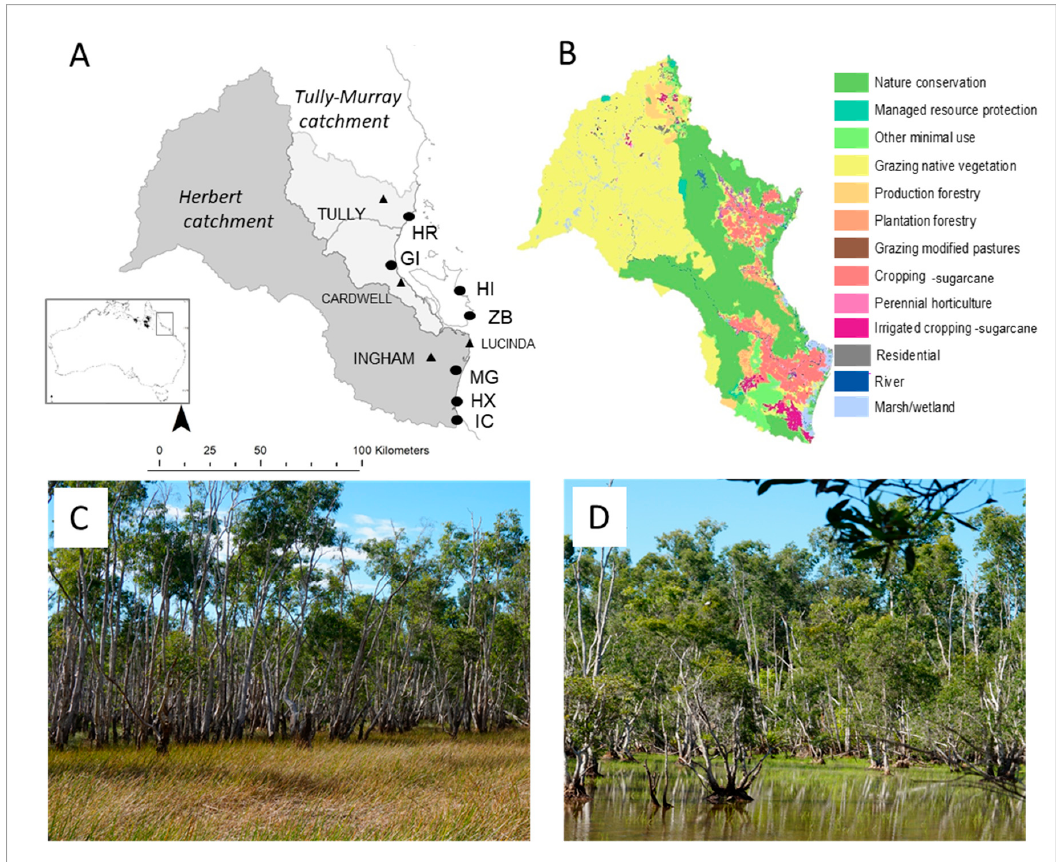
Figure 1. ( A ) Location of seven forested floodplain wetlands dominated by Melaleuca spp. in northeast Australia. Triangles represent main population centres: Tully (population of 2390), Cardwell (population of 1309), and Ingham (population of 4357); ( B ) Land uses for the Tully-Murray and Herbert River catchments. Data are from the Queensland Spatial Catalogue, Queensland Government, Australia [27]. ( C ) Girramay National Park, during the dry, and ( D ) wet season. We sampled seven sites dominated by Melaleuca spp., commonly known as “tea tree swamps”.